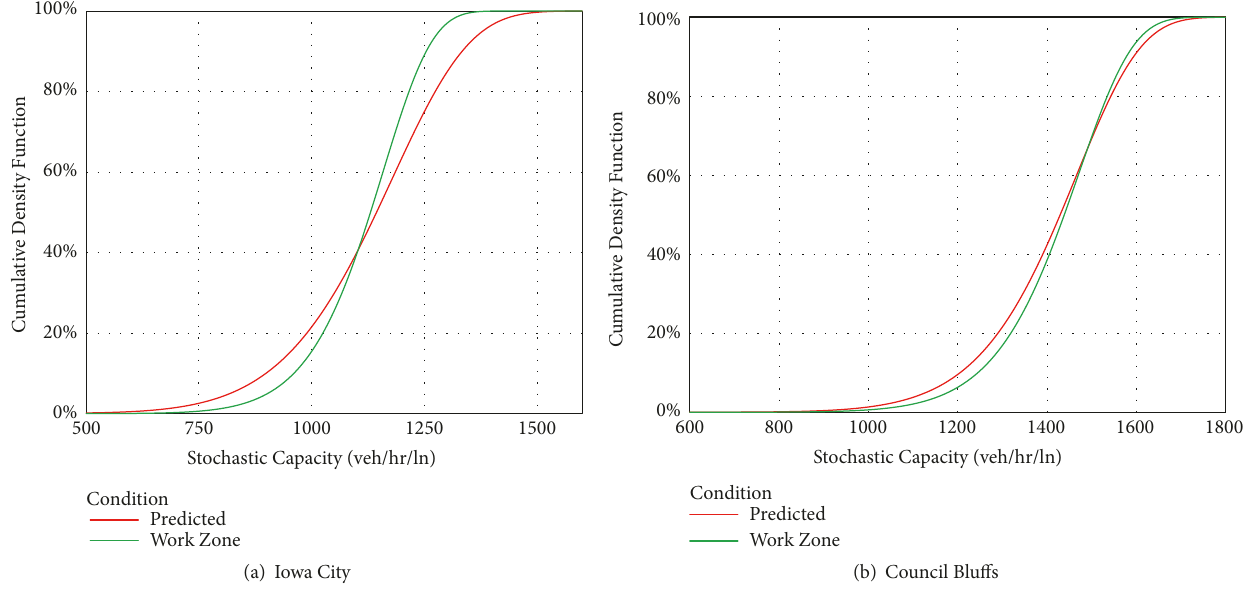
Figure 7: Predicted and estimated stochastic capacity distributions.